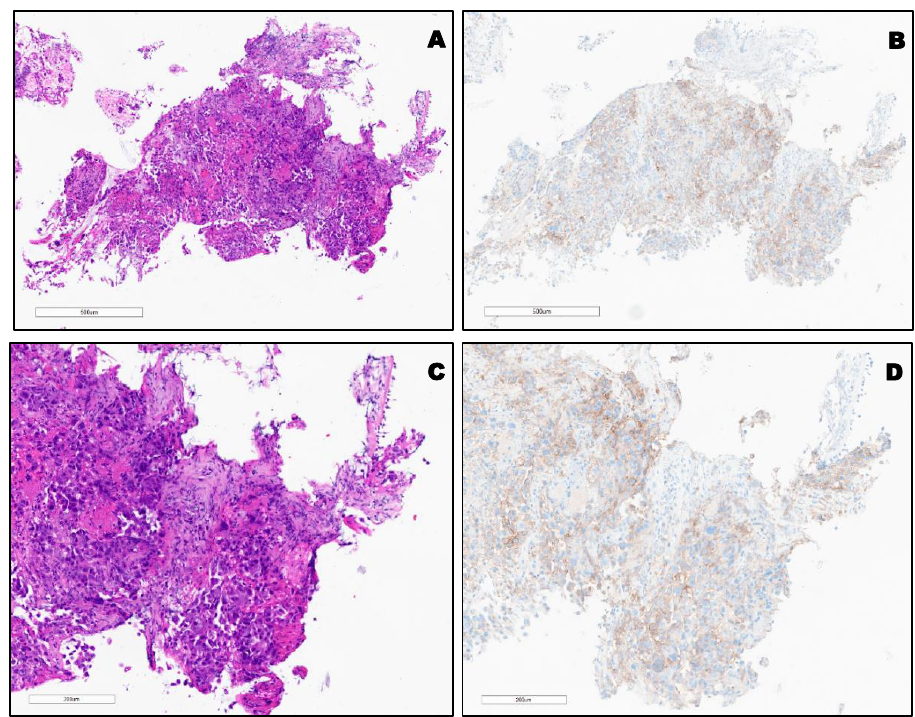
Figure 3. ( A , C ) H&E of KRAS mutated (G12C) poorly differentiated SCC. ( B , D ), TPS: 30% using PD-L1 (22C3) FDA (Keytruda ® ).